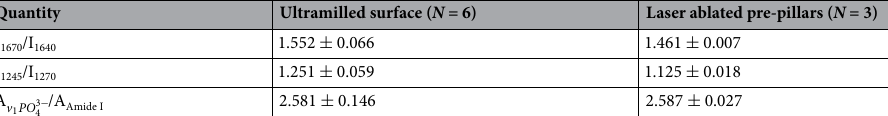
Table 2. Overview of Raman results for ultramilled surface and laser ablated pre-pillars including amide I and III intensity ratios and integrated areas mineral-to-matrix ratio. The values are presented as mean ± SD